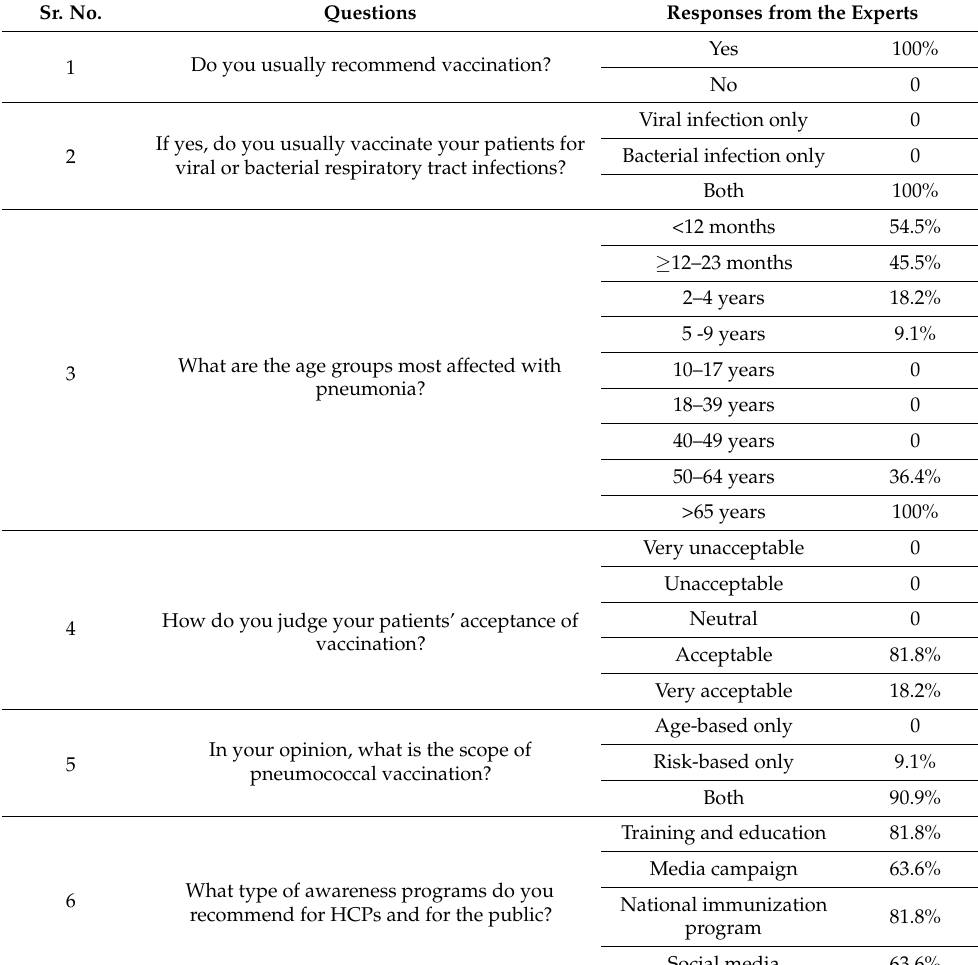
Table 3. Criteria for vaccination: expert